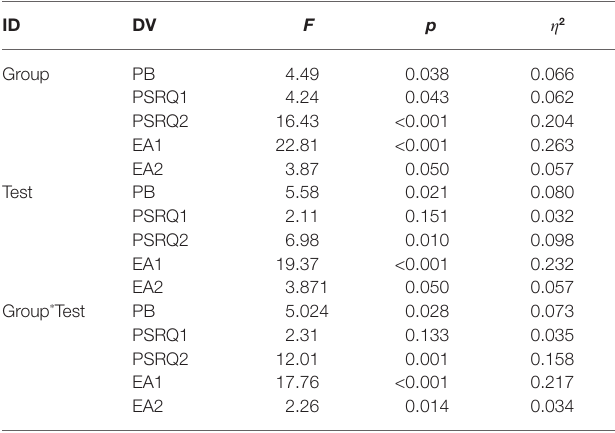
TABLE 2 | Results between-subjects